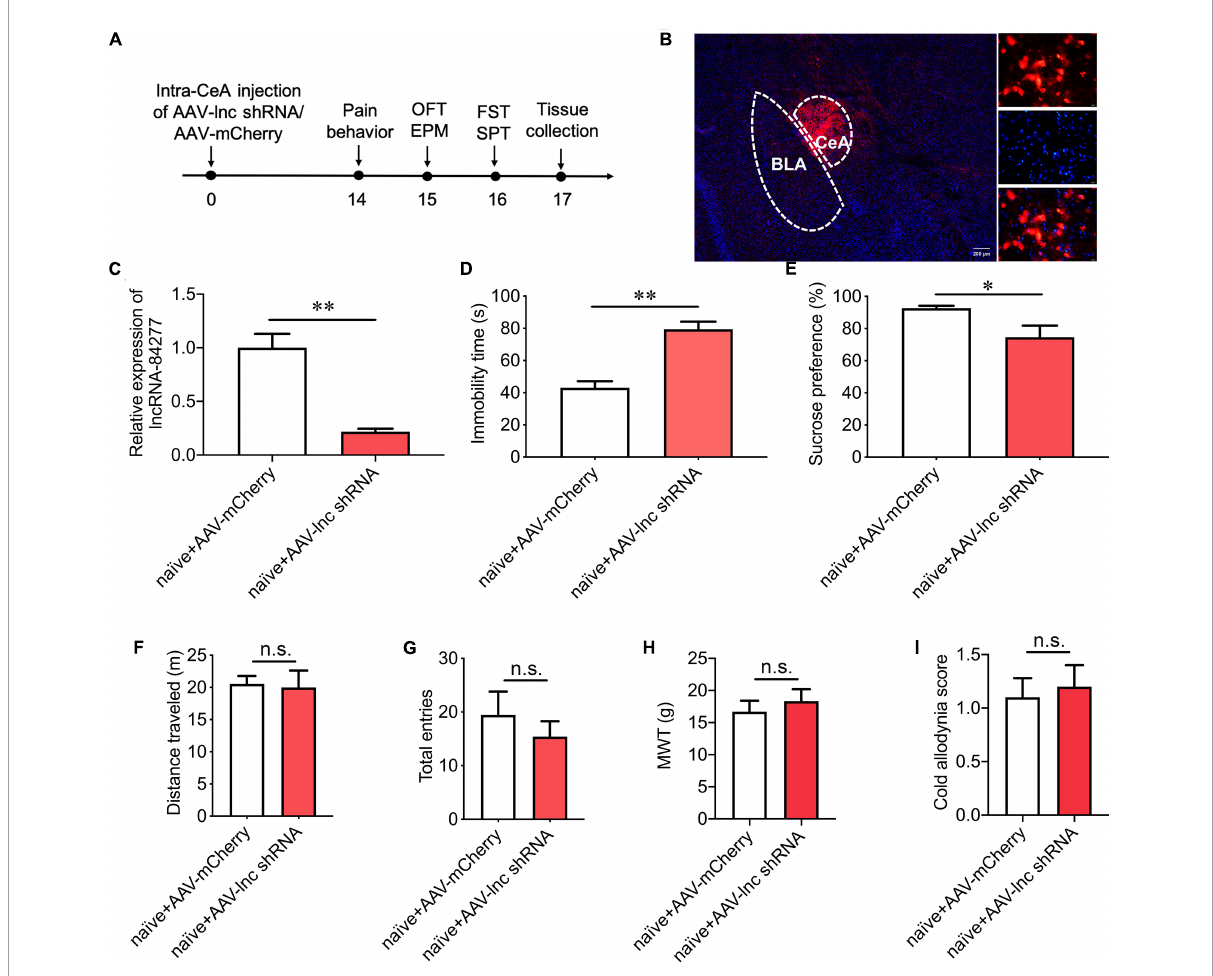
FIGURE3 LncRNA-84277 knockdown in CeA induces depression-like behaviors in naïve rats. (A) Experimental timeline. (B) mCherry fluorescence in CeA after injection of an AAV vector carrying lncRNA-84277-specific shRNA (AAV-lnc shRNA). (C) RT-qPCR analysis of lncRNA-84277 expression in CeA after injection of AAV-lnc shRNA ( n = 8). (D,E) Effect of lncRNA-84277 knockdown on depression-like behaviors in naïve rats assessed by the immobility time in the forced swim test (D) and sucrose consumption in the sucrose preference test (E) ( n = 8–10). (F,G) Effect of lncRNA-84277 knockdown on locomotor activity in naïve rats assessed by the total distance traveled in the open field test (F) and the total entries to open arms and closed arms in the elevated plus-maze test (G) ( n = 10–11). (H,I) Effect of lncRNA-84277 knockdown on sensory pain in naïve rats assessed by the mechanical withdrawal threshold (MWT) for mechanical allodynia (H) and the cold allodynia score for cold allodynia (I) ( n = 10). All data are expressed as the mean ± SEM. ∗ P < 0.05, ∗∗ P < 0.01. n.s., not significant. OFT, open field test; EPM, elevated plus-maze test; FST, forced swim test; SPT, sucrose preference